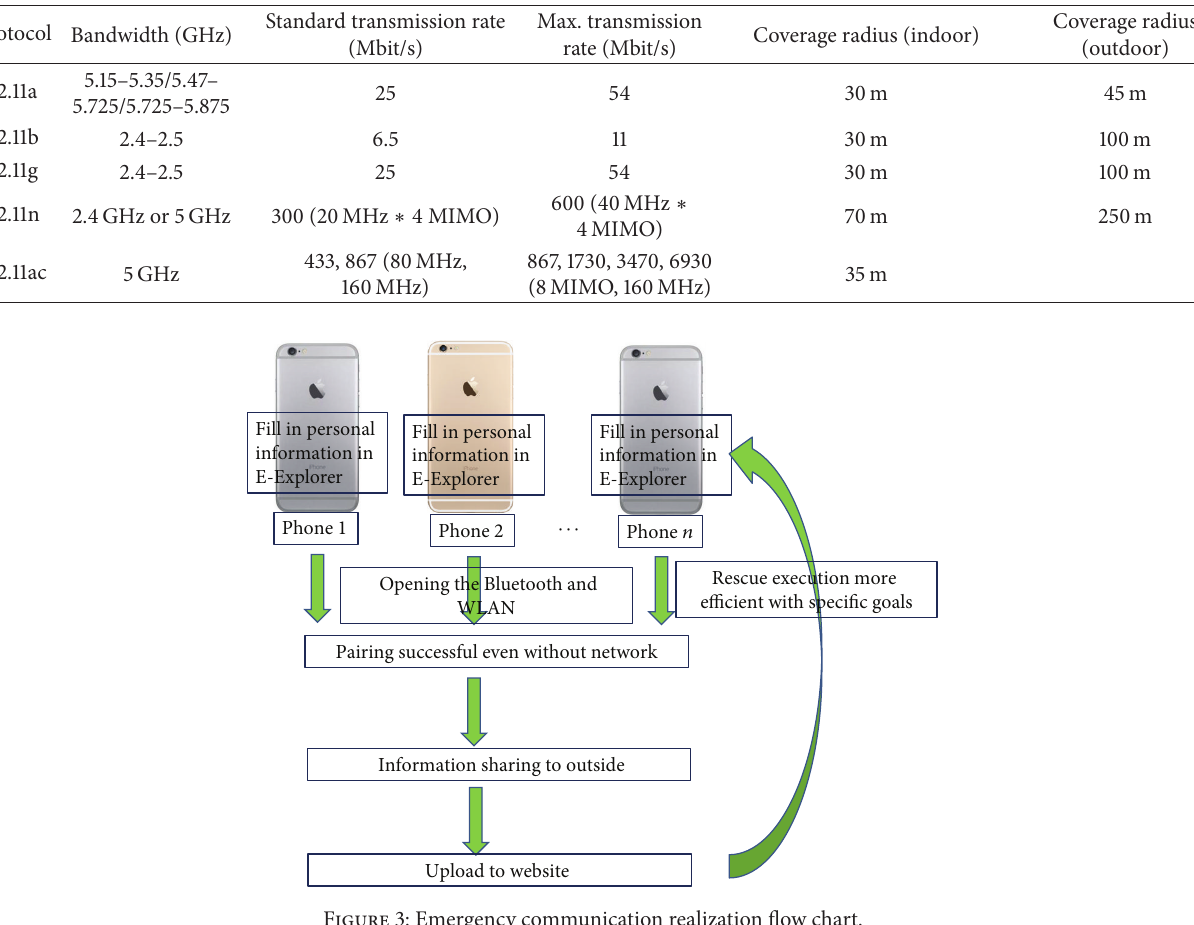
Table 2: Characteristics of the communication protocol used in iPhone.